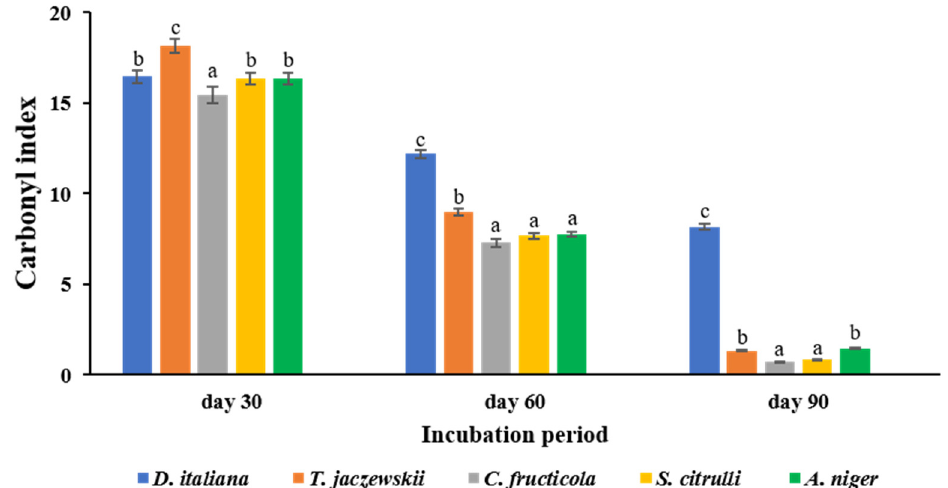
Figure 6. Spectra from FTIR analysis of LDPE films cultured with D. italiana , T. jaczewskii , C. fructicola , S. citrulli , and A. niger after 30 ( A ), 60 ( B ), and 90 ( C ) days of incubation.